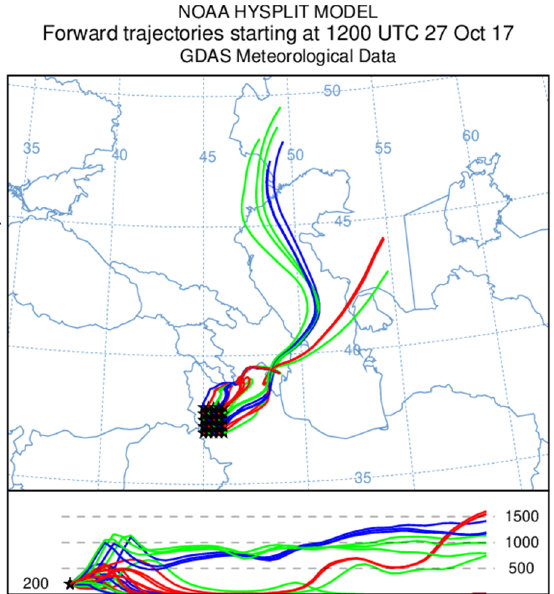
Figure 9. The output of HYSPLIT Model in forwarding trajectory method, at 12 UTC on the 27 October 2017.